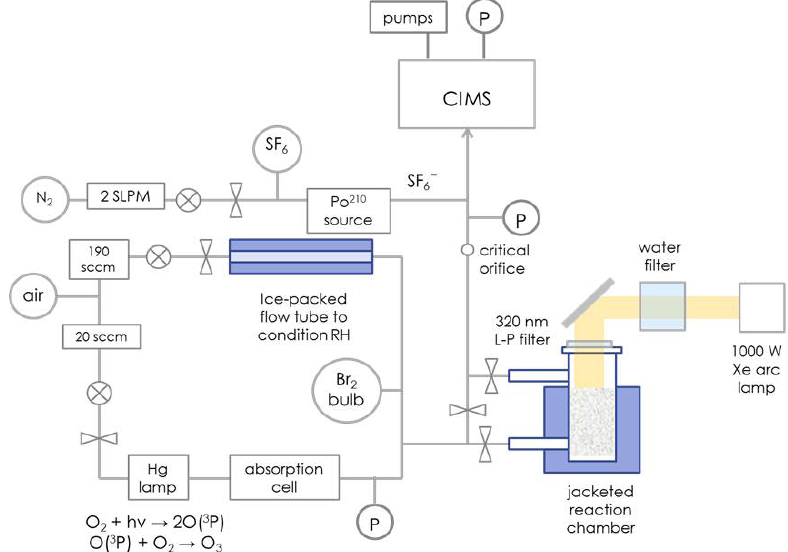
Fig. 1. Schematic of experimental